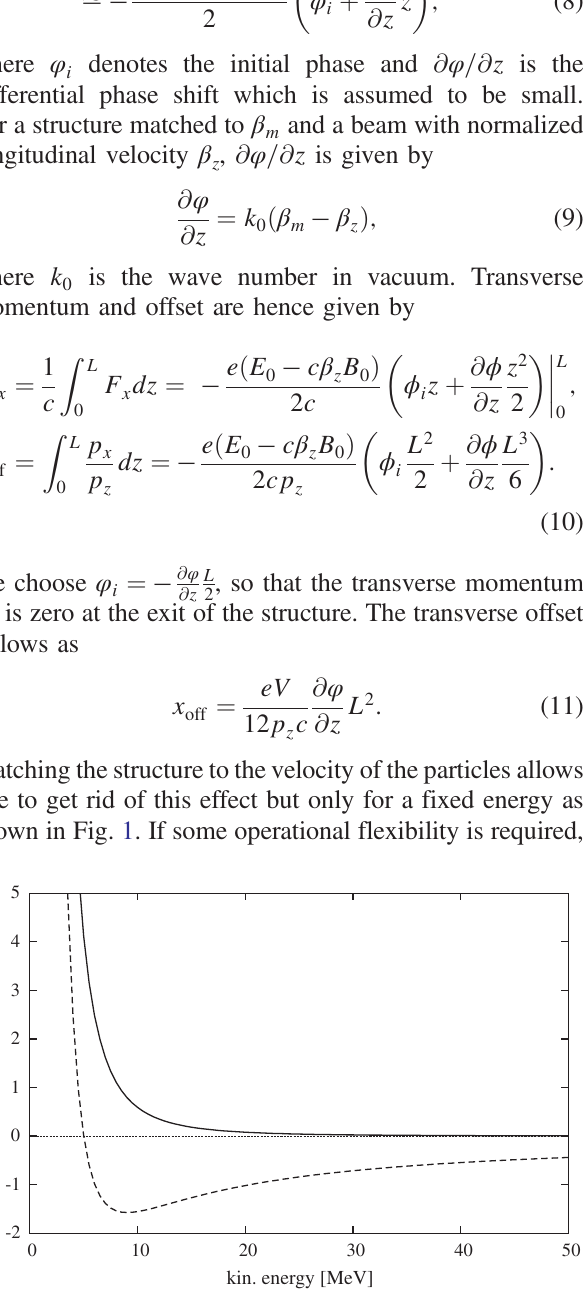
FIG. 1. Transverse offset due to velocity mismatch vs particle energy according to Eq. (11) with V ¼ 1 MV, L ¼ 1 m, k 0 ¼ 2 π = 0 . 1 m − 1 . The solid line is for β line is matched to 5 MeV particle